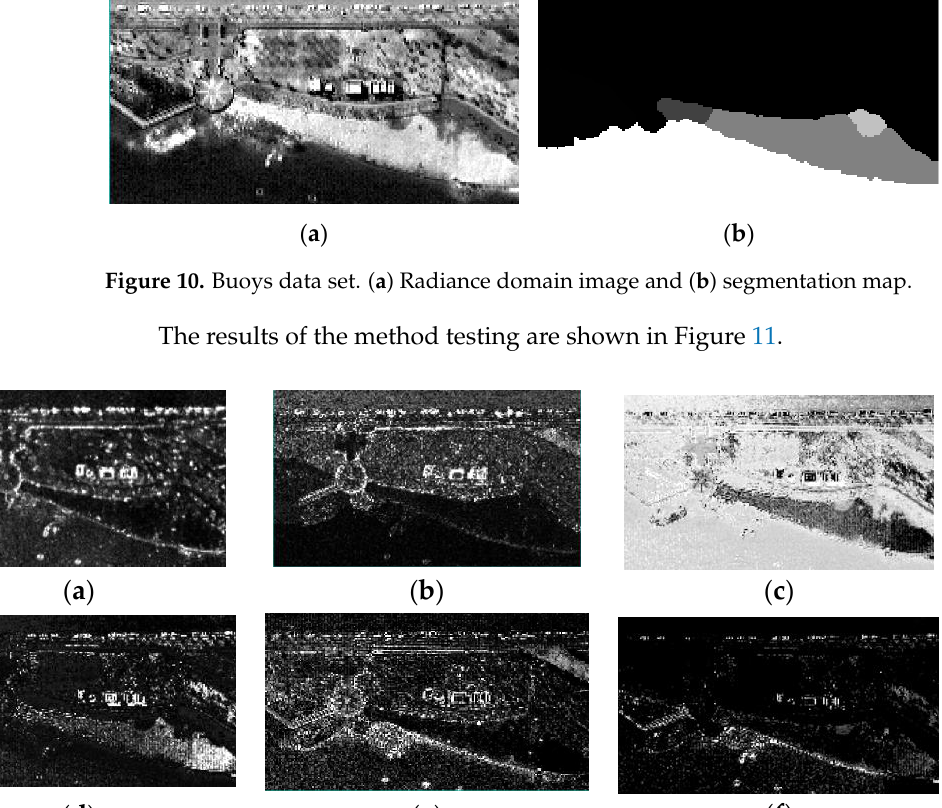
Figure 9. Buoys data set . ( a ) Radiance domain. ( b ) Temperature image; ( c ) emissivity RGB pseudo-color image synthesized by band 8, 11, 25; ( d ) ground-truth map; ( e ) RGB image; and ( f ) emissivity spectral signatures of anomalies and background. After AC and TES, the radiance image and temperature image were used to generate homogeneous regions. Figure 10 shows the segmentation map.